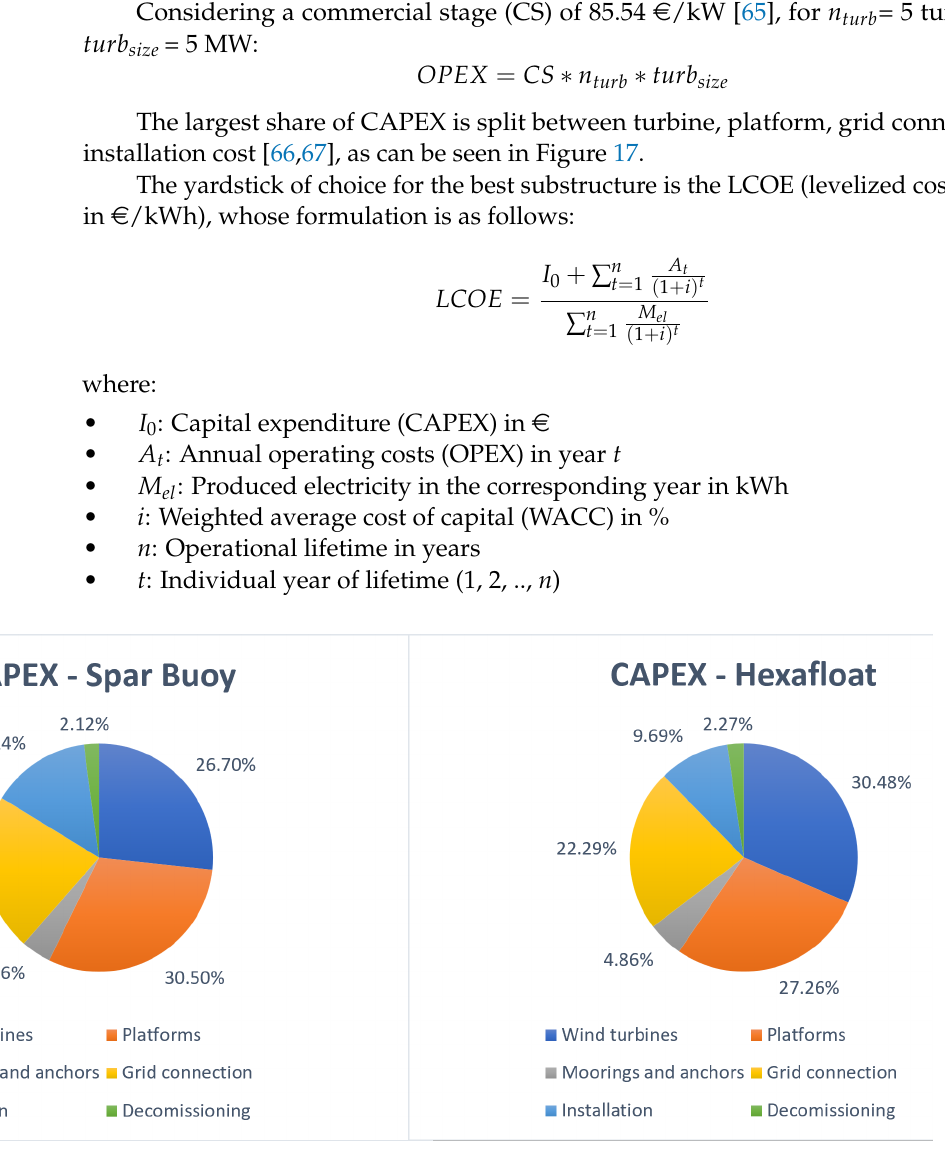
Figure 17. Offshore wind farm CAPEX sub-division for optimized spar and hexafloat.